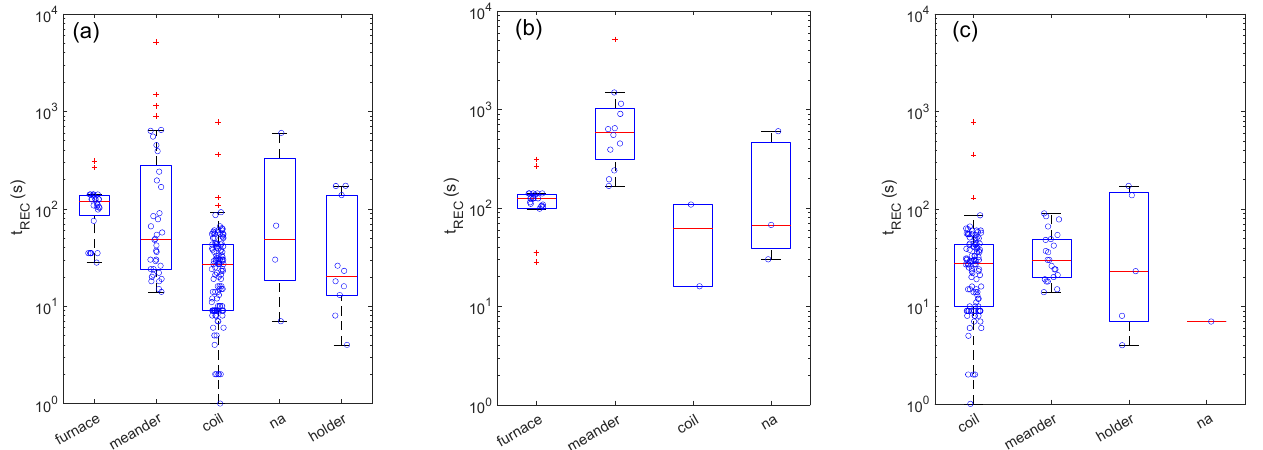
Figure 4. Heating method effects on recovery times (t REC ) for measurements. Boxplots showing the distribution of t REC for different heating methods for the whole set of measurements ( a ) and for the sub-set of measurements carried out with dynamic ( b ) and static ( c ) setups. In all plots, ‘na’ stands for ‘not available’—for those papers that did not provide enough detail to properly identify the class of the descriptive parameter.